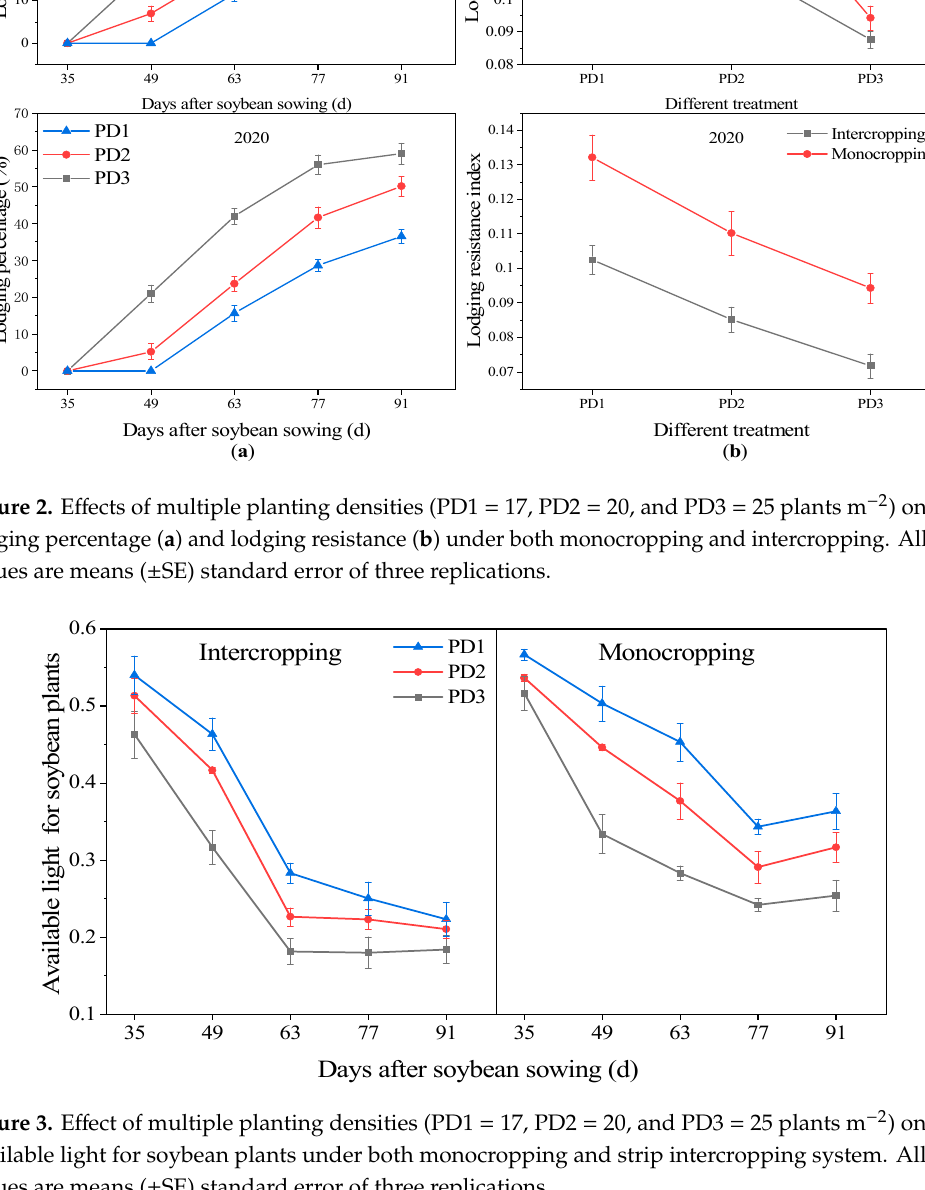
Figure 2. Effects of multiple planting densities (PD1 = 17, PD2 = 20, and PD3 = 25 plants m − 2 ) on the lodging percentage ( a ) and lodging resistance ( b ) under both monocropping and intercropping. All the values are means (±SE) standard error of three replications.